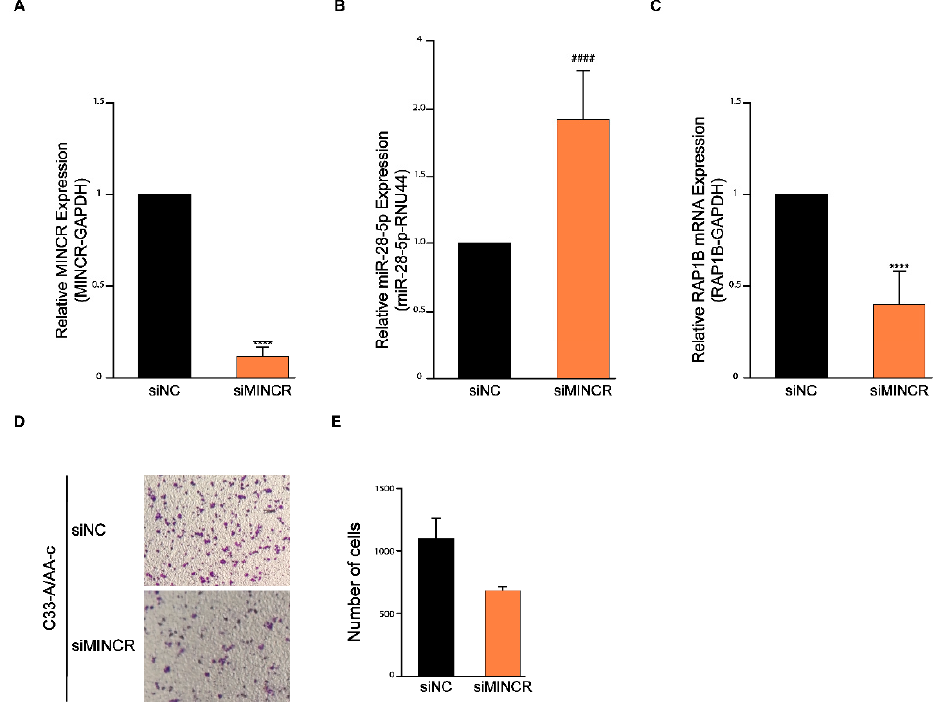
Figure 4. MINCR regulates migration in C33 ‐ A/AA ‐ c cells through modulating the expression of miR ‐ 28 ‐ 5p and RAP1B. ( A ) Expression of MINCR after 24 h post ‐ transfection of C33 ‐ A/AA ‐ c cells with 5 pmol of siRNA targeting MINCR (knockdown) and siRNA control. ( B , C ) Relative expression of miR ‐ 28 ‐ 5p and RAP1B mRNA by RT ‐ qPCR after MINCR knockdown in C33 ‐ A/AA ‐ c cells. As endogenous controls, RNU44 and GAPDH were used for miR ‐ 28 ‐ 5p and RAP1B, respectively. ( D , E ) Transwell cell migration assay. C33 ‐ A/AA ‐ c cells were previously transfected with siRNA targeting MINCR and incubated in the transwell chamber for 48 h. The number of migrating cells was determined with ImageJ software. Student’s t ‐ test, **** p < 0.0001; Mann–Whitney–Wilcoxon test, #### p < 0.0001.